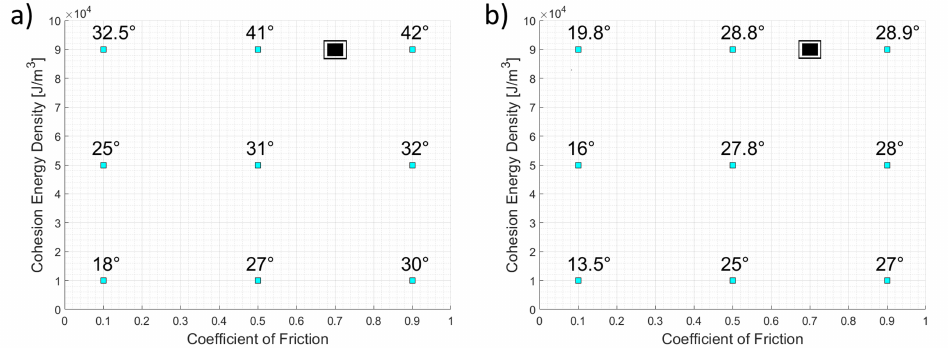
Figure 3. Effect of the variation of the coefficient of friction and cohesion energy density on the slipping angle ( a ) and angle of repose ( b ). The black rectangle is the best combination that reproduces the target